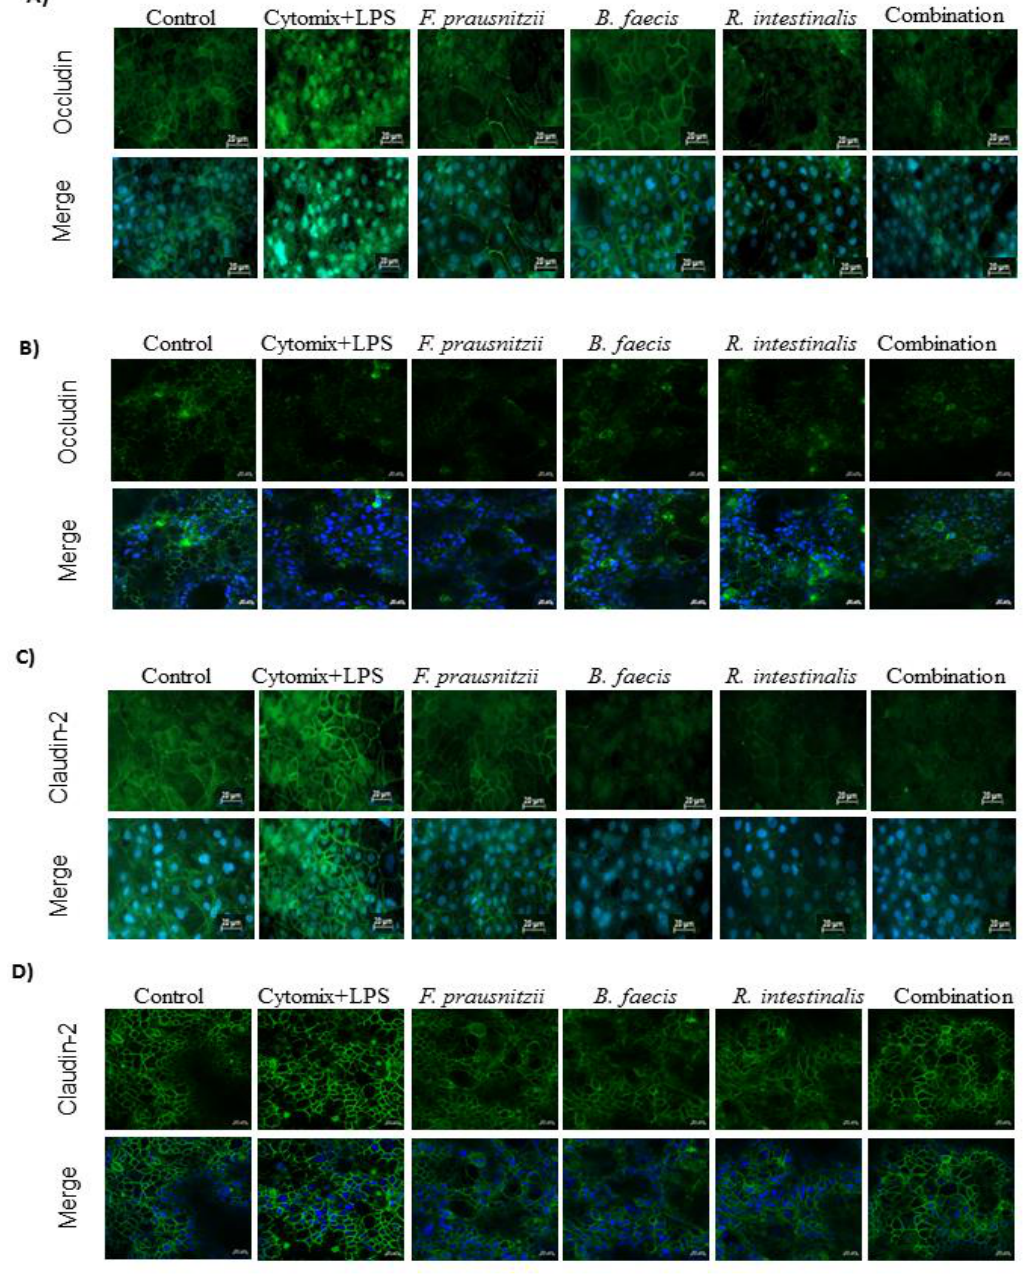
Figure 5. Effect of F. prausnitzii , B. faecis and R. intestinalis alone and in combination on the immunofluorescence localization of tight junction proteins. Both cell line monolayers were incubated with all three bacteria alone and in combination following incubation, cell monolayers were fixed and stained with anti-occludin and claudin-2 antibodies (green) and Hoechst (blue) and imaged by confocal microscopy. Immunofluorescence staining of Occludin in Caco-2 ( A ) and HT29-MTX ( B ) cell monolayers. Immunofluorescence staining of claudin-2 in Caco-2 ( C ) and HT29-MTX ( D ) cell monolayers. Images are of 40 × magnification. Bar = 20 µm.